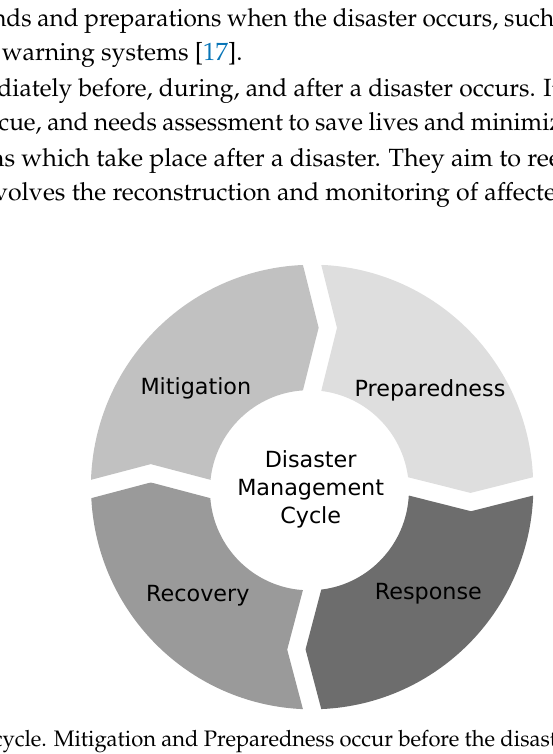
Figure 1. The DM cycle. Mitigation and Preparedness occur before the disaster indeed, while Response is immediately before and after it. Recovery always happens after the occurrence of a disaster. Note that the DM cycle tends to make affected regions better prepared when another disaster